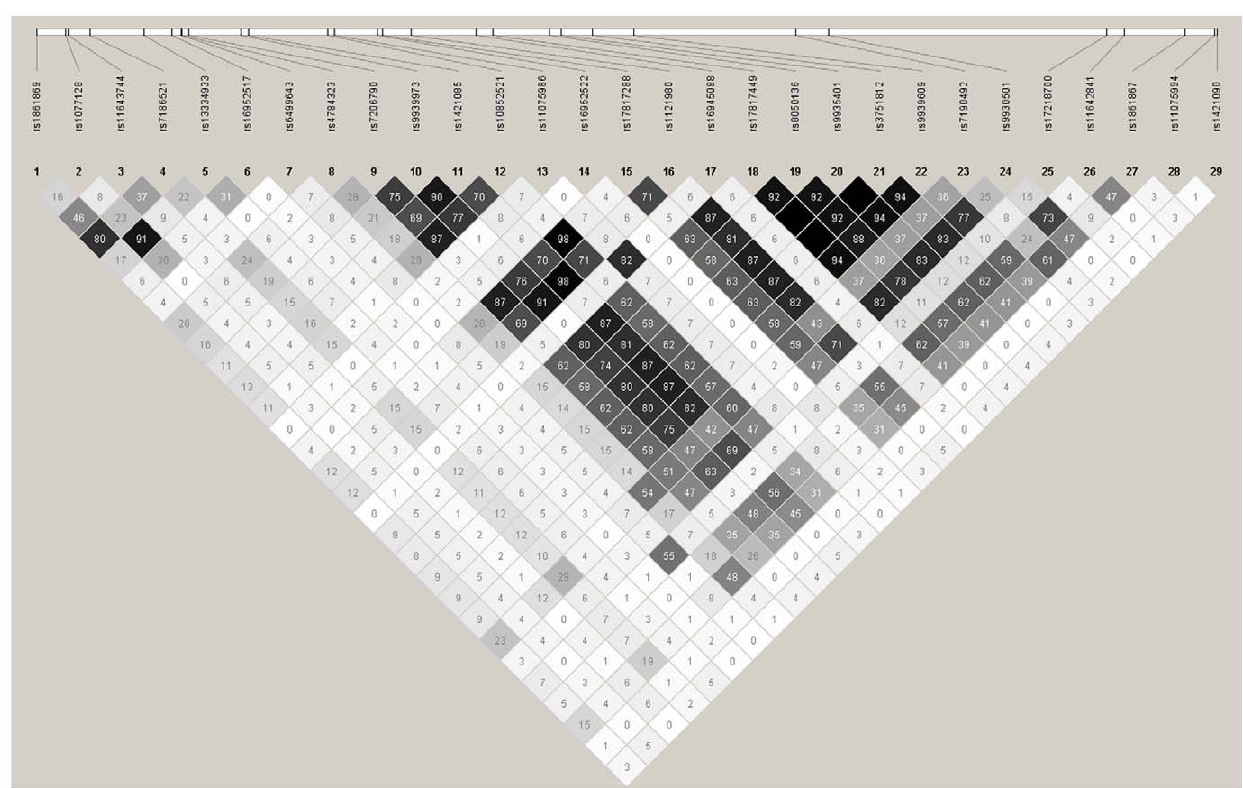
Figure 3. Distribution and pairwise LD ( r 2 ) map of the 29 SNP markers.